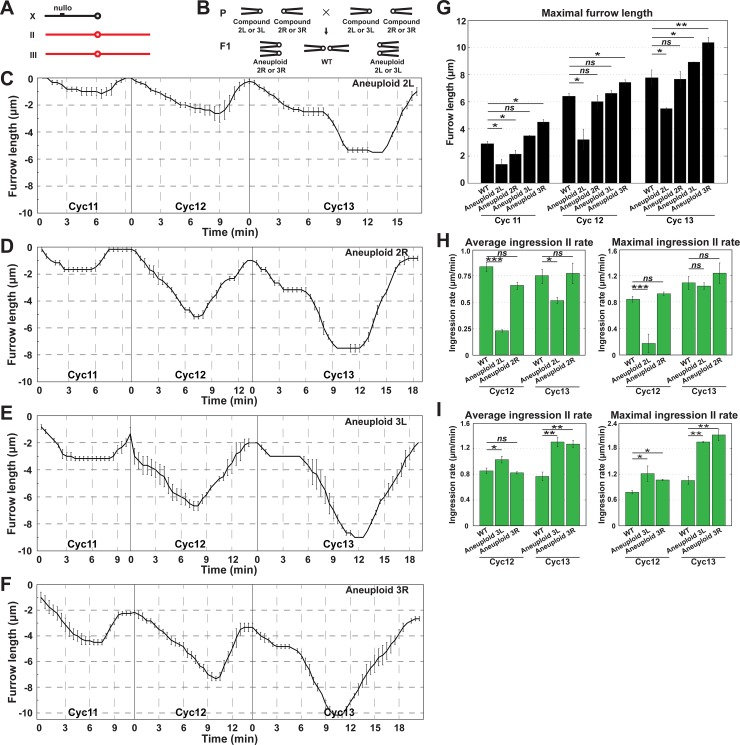
Autosomal contributions to furrow regulation.(A) The major Drosophila chromosomes, with the metacentric autosomes indicated in red. (B) Schematic depicting segregation of compound chromosomes generating 2L, 2R, 3L or 3R aneuploidy. (C) Aneuploid 2L furrow dynamics (n = 3). (D) Aneuploid 2R furrow dynamics (n = 4). (E) Aneuploid 3L furrow dynamics (n = 3). (F) Aneuploid 3R furrow dynamics (n≥3). (G) Maximal furrow length of WT, aneuploid 2L, 2R, 3L and 3R during cycles 11–13 (n≥3). *:p<0.05; **: p<0.005; ***: p<0.0005; ns: not significant. (H) Average and maximal Ingression II rates of WT, aneuploid 2L and 2R embryos during cycles 11–13 (n≥3). *:p<0.05; ***: p<0.0005; ns: not significant. (I) Average and maximal Ingression II rates of WT, aneuploid 3L and 3R embryos during cycles 11–13 (n≥3). *:p<0.05; **: p<0.005; ***: p<0.0005; ns: not significant.